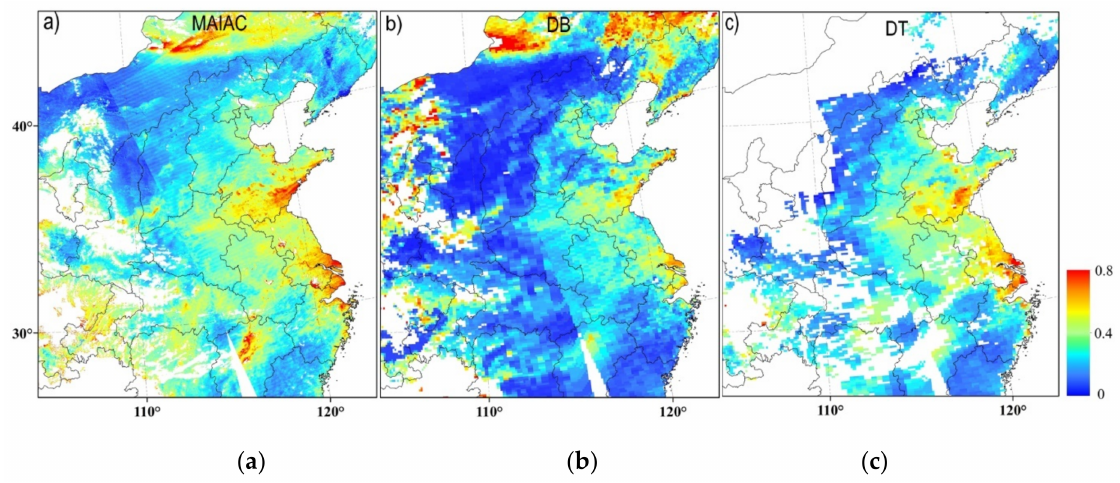
Figure 4. MODIS MAIAC ( a ), DB ( b ) and DT ( c ) AOD in northern China during Aril 29,